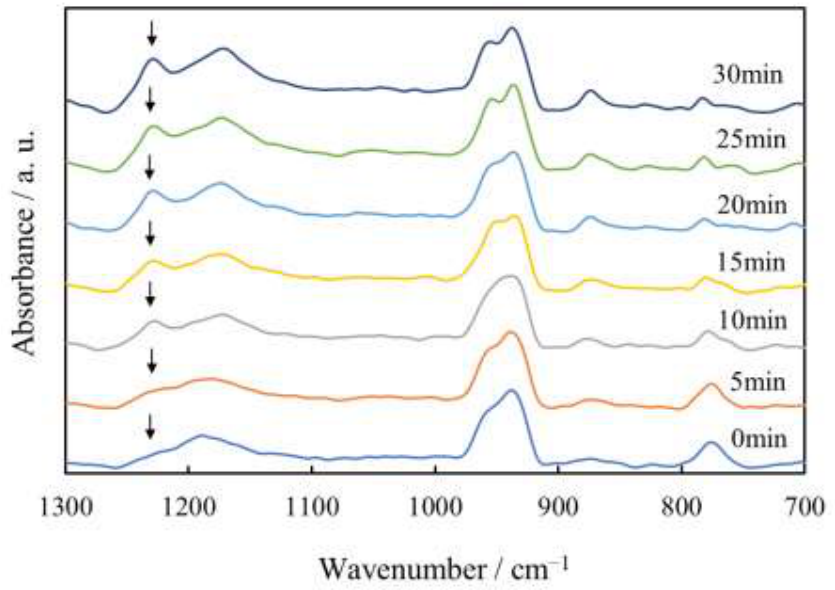
Figure 9. Time resolved FT-IR spectra of γ -spherulite of PVDF/TBAHS during isothermal crystallization at 165 °C.